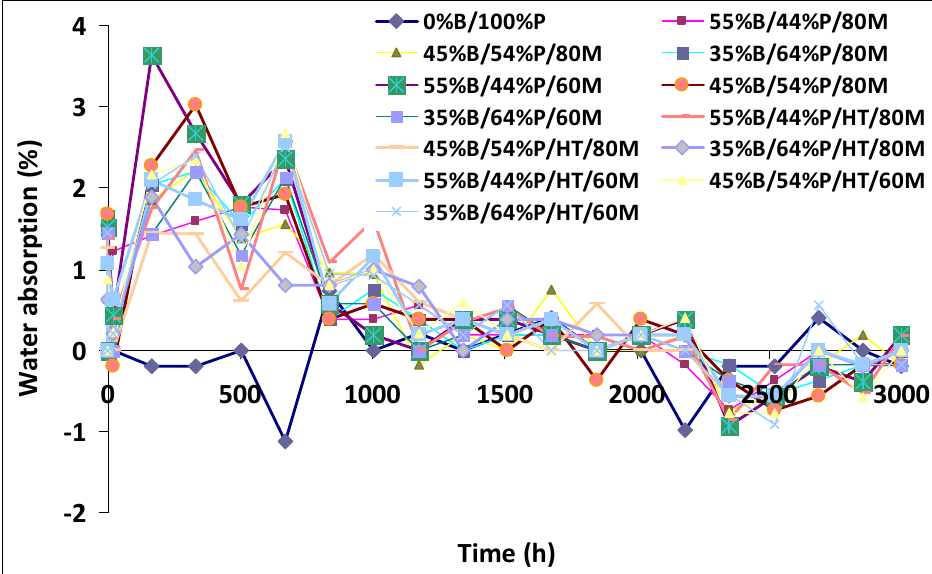
Figure 4. Effect of bamboo content on water absorption of bamboo (B)/plastic (P) composites composed of different plastics. M: mesh size, HT: heat treatment. Table 6. Biological decomposition of bamboo/plastic composites composed of different plastics [79].